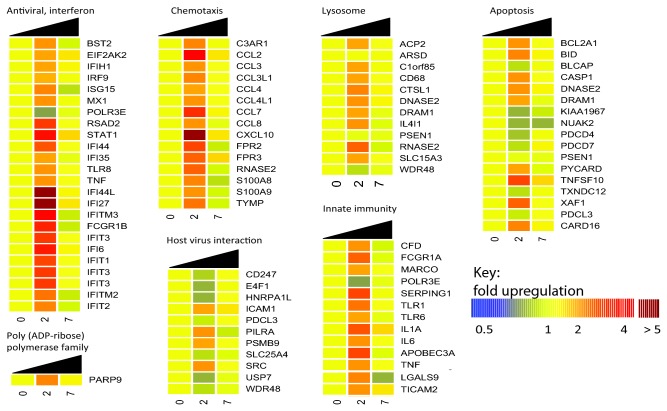
Transcriptional response to MVA85A.Heat map showing changes fold change in gene expression of common genes 2 and 7 days following MVA85A vaccination. The genes are sorted into categories based on DAVID Bioinformatics Database gene descriptions. The heat map colours show the average expression across the 24 volunteers at each time point (given in days at the bottom of each column).